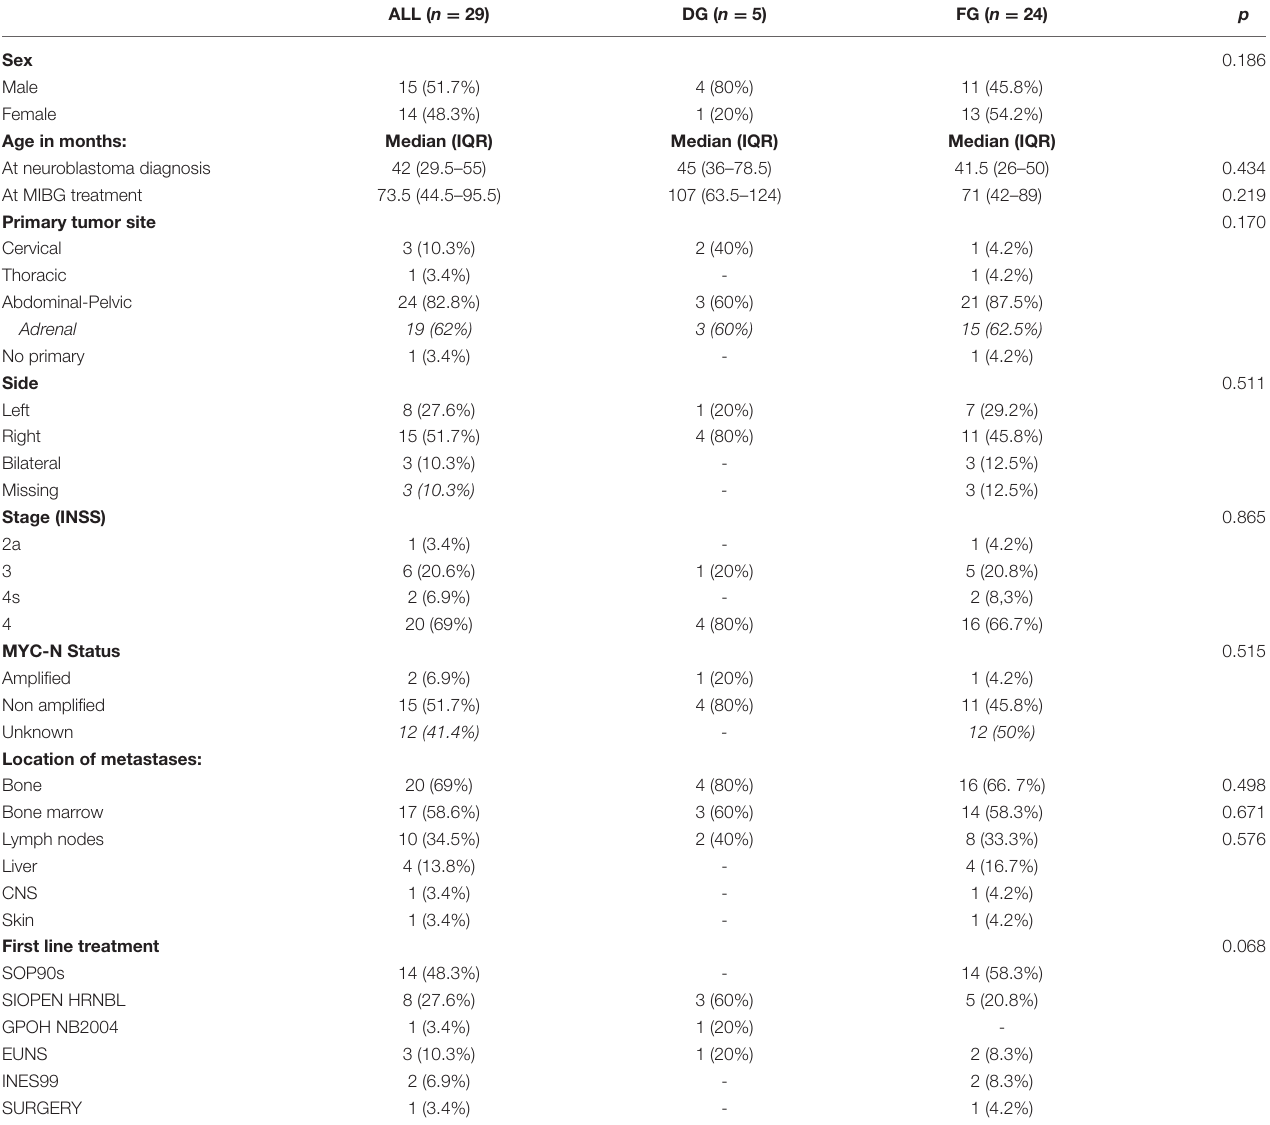
TABLE 1 | Patients